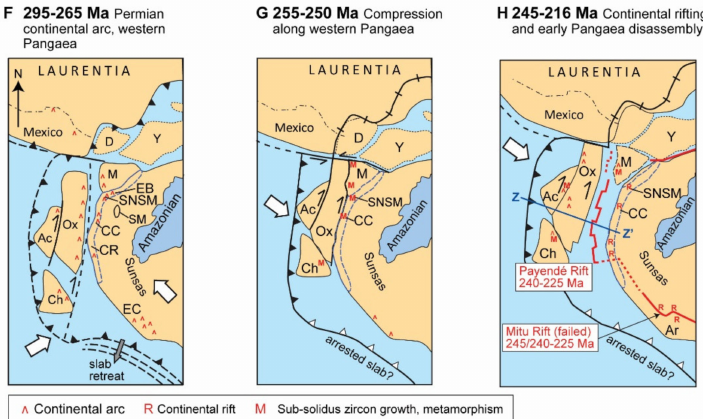
Figure 8. ( A – E ) Plate reconstructions for the Palaeozoic margin of northwestern Gondwana, modified and simplified from Cocks and Torsvik (2006) [100] and Van der Lelij et al. (2016) [2]. The location of the Huarguall á Gabbro and other basement sequences are shown, along with the Espino Graben, and some sedimentary formations (labelled in black). ( F – H ) Tectonic reconstructions for the Permian and Triassic, modified after Dickinson and Lawton (2001) [101], El í as-Herrera and Ortega-Guti é rrez (2002) [102], Weber et al. (2007) [27], Spikings and Paul (2019) [1], and Spikings et al. (2021)